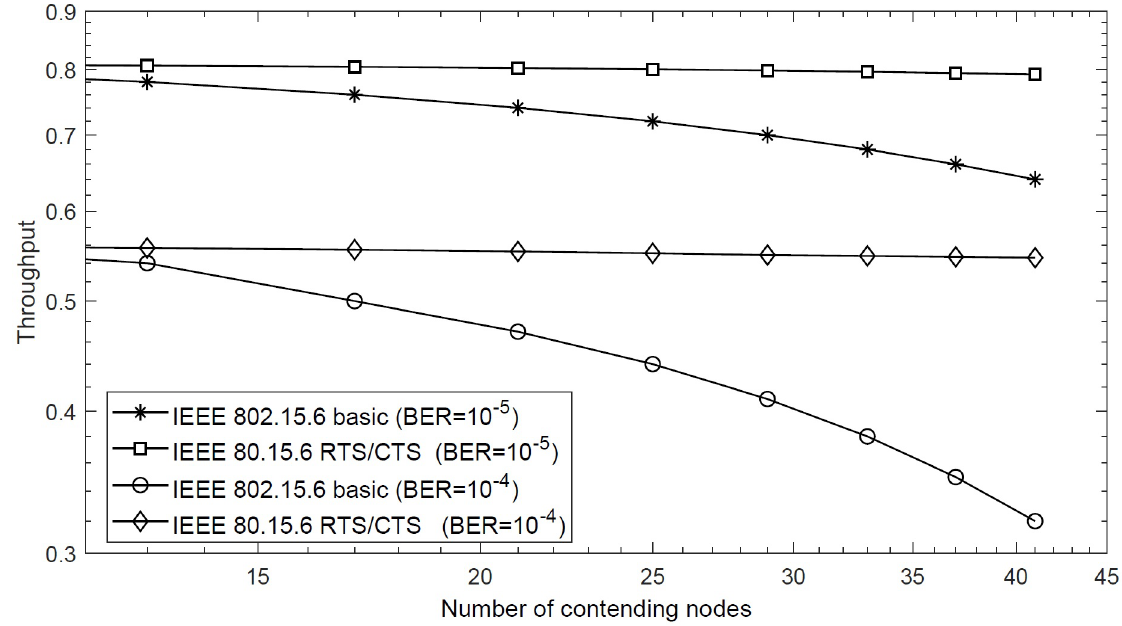
Figure 5. Saturation throughput of the RTS/CTS scheme for IEEE